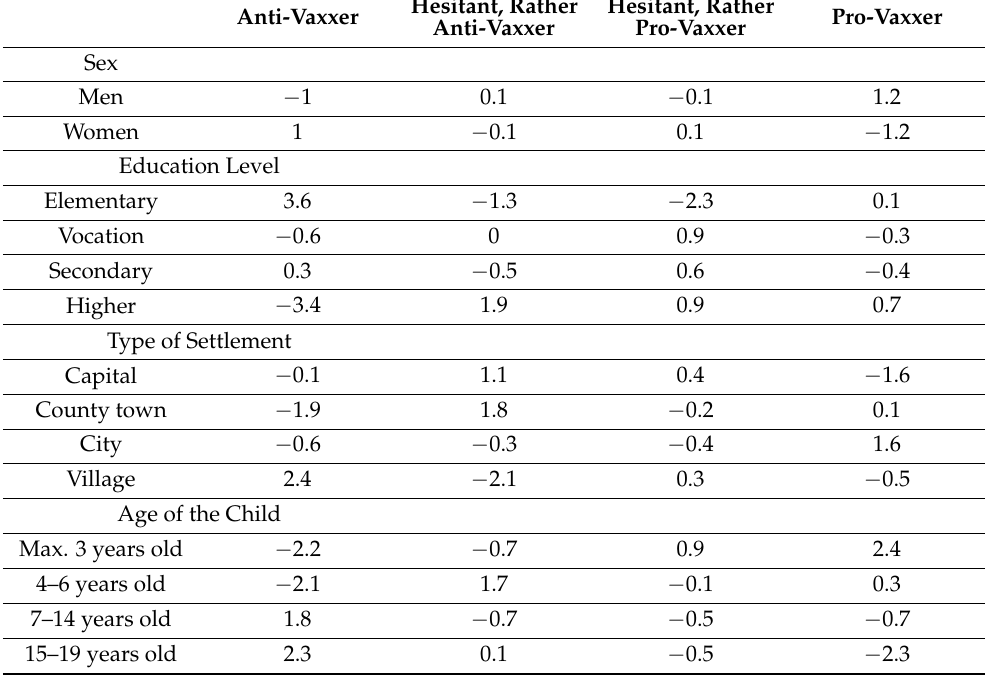
Table A6. Crosstabulation of the general attitudes towards vaccination with different socio- demographic dimensions. Standardized Pearson residuals. (If the standardized Pearson residuals are larger than 2 in absolute value, we interpreted it that the cell is significantly different from the expected value of independence on a 0.05